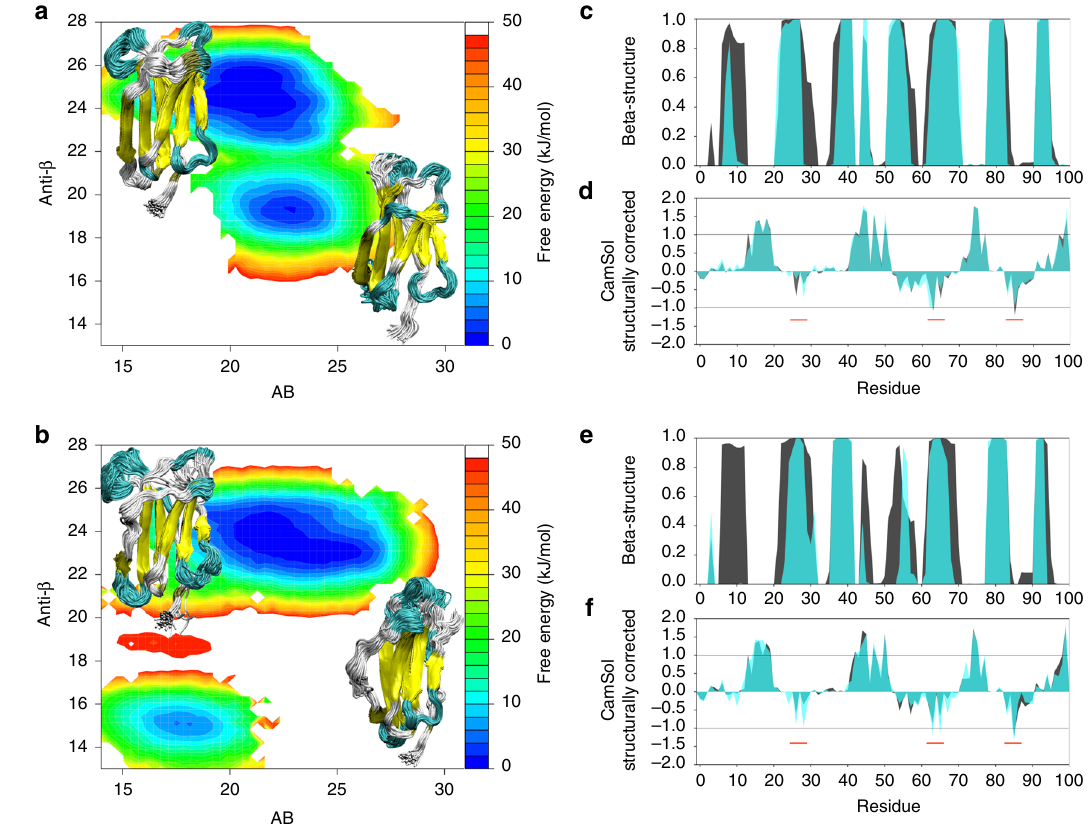
Fig. 4 Conformational ensembles for native β 2m variants. Free energies surfaces (kJ/mol), secondary structure content and solubility for the wt (upper panels) and D76N (lower panels) ensembles. a , b Free energy surfaces for the wt and D76N variant, respectively. The surfaces are shown as a function of the side chains rotameric state, AB, and the antiparallel β -structure content (anti- β ) with a set of representative conformations for the major and minor substates. c , e Beta structure content per residue (within each ensemble) for the wt and D76N variants, respectively. The major state is shown in black, while the minor in cyan. d , f CamSol solubility scores for wt and D76N, respectively. Scores greater than 1 suggest a highly soluble site while a score lower than − 1 suggest an aggregation-prone site. The major state is shown in black while the minor in